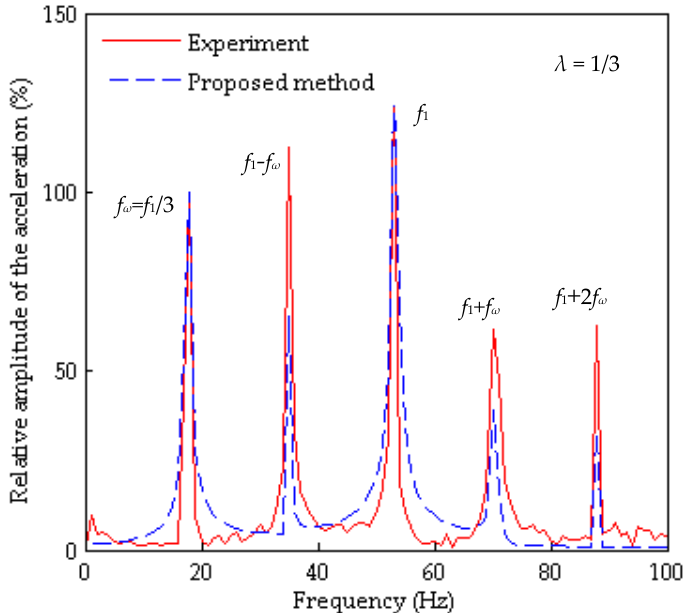
Figure 9. Fast Fourier transform (FFT) spectrum of the transverse acceleration at the tip of the cracked beam with λ = 1/3.